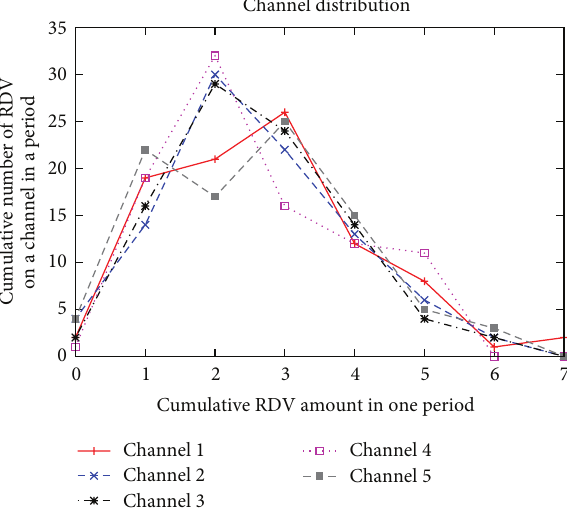
Figure13:Asymmetricchannelset:combinationofmapswith5and 7